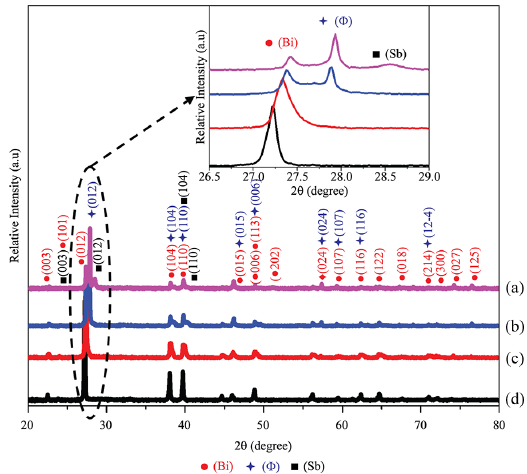
Figure 1. XRD patterns of different compositions of alloy, prepared at 140 °C for 12h (a) Bi and (d) Bi